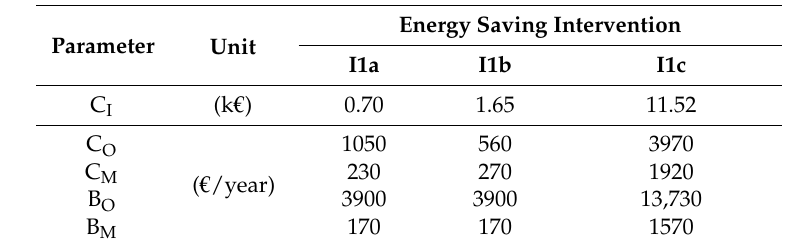
Table 4. Calculation results: economical parameters for different energy saving interventions (lamp replacement interventions).